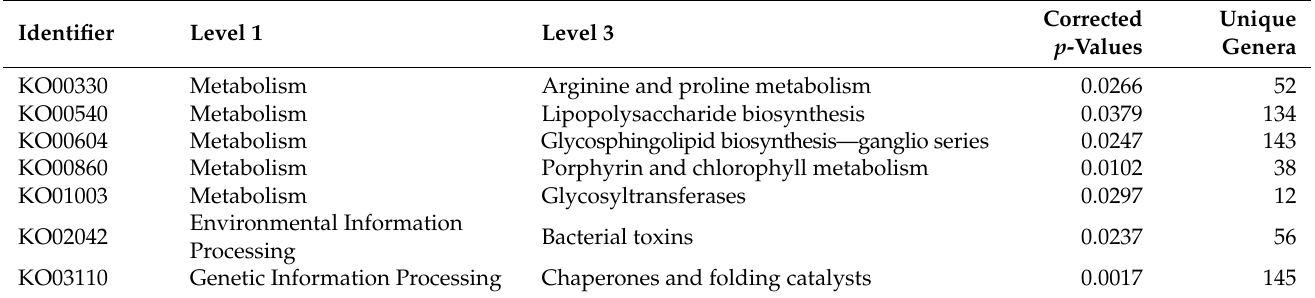
Table A3. Metabolic and signaling pathways differentially represented in the three locations. Identifier indicates the unique KEGG id (Kanehisa et al., 2010 [43]), while Level 1 and Level 3 are the correspond- ing KEGG pathway categories, and Unique genera are OTUs pertaining to a given pathway.